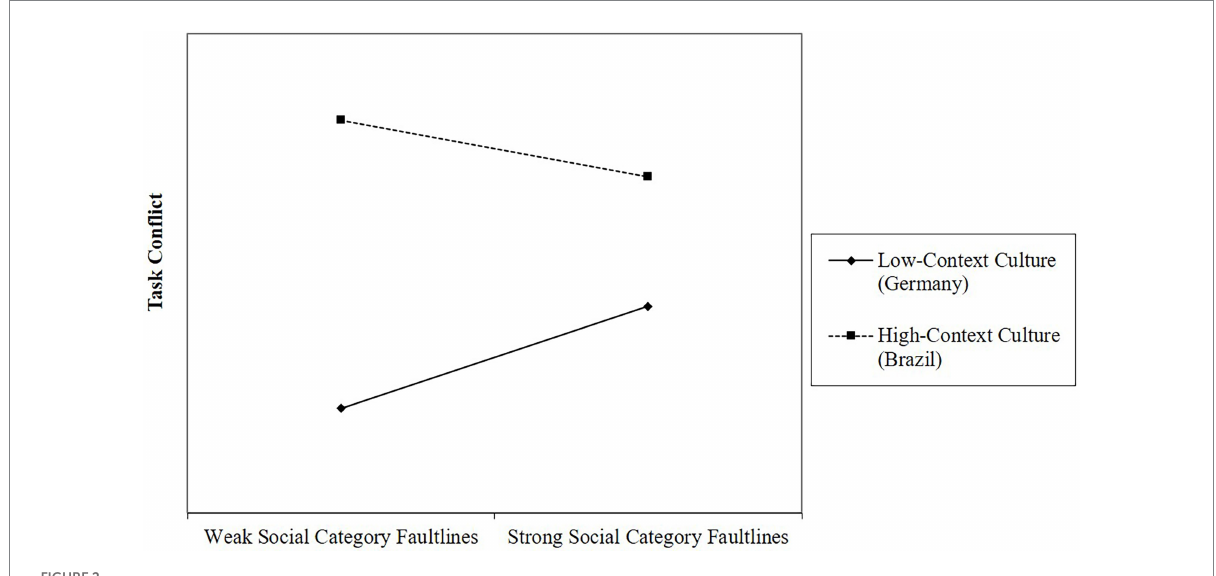
FIGURE 2 Conditional effects of social category faultline strength on task conflict.